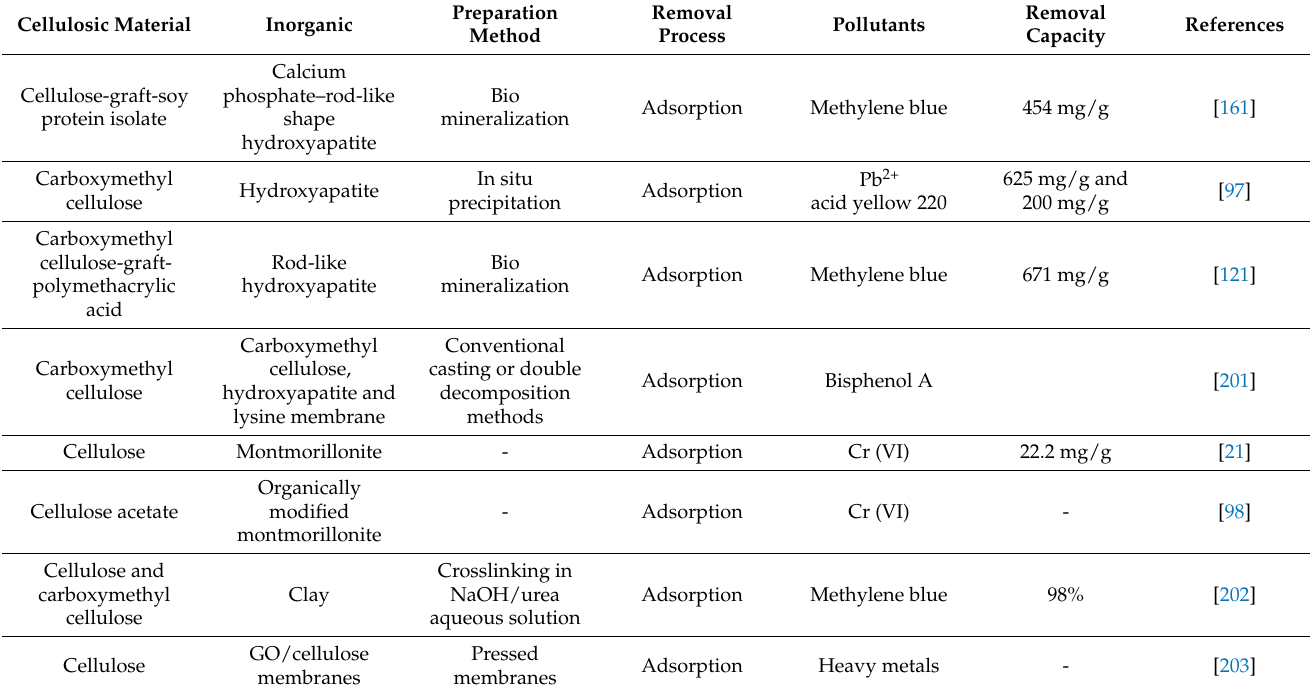
Table 6. Nanocellulose/inorganic composites as effective wastewater cleaning